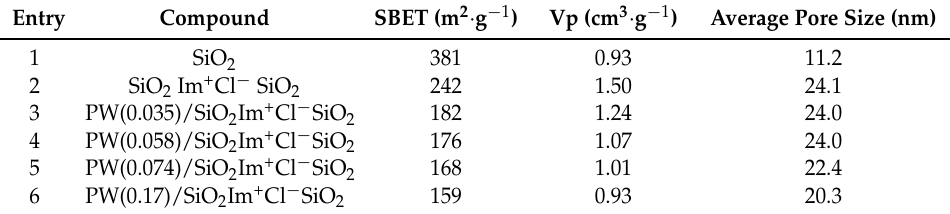
Table 1. BET parameters of the SiO 2 , SiO 2 Im + Cl ´ SiO 2 , and PW( x )/SiO 2 Im + Cl ´ SiO 2